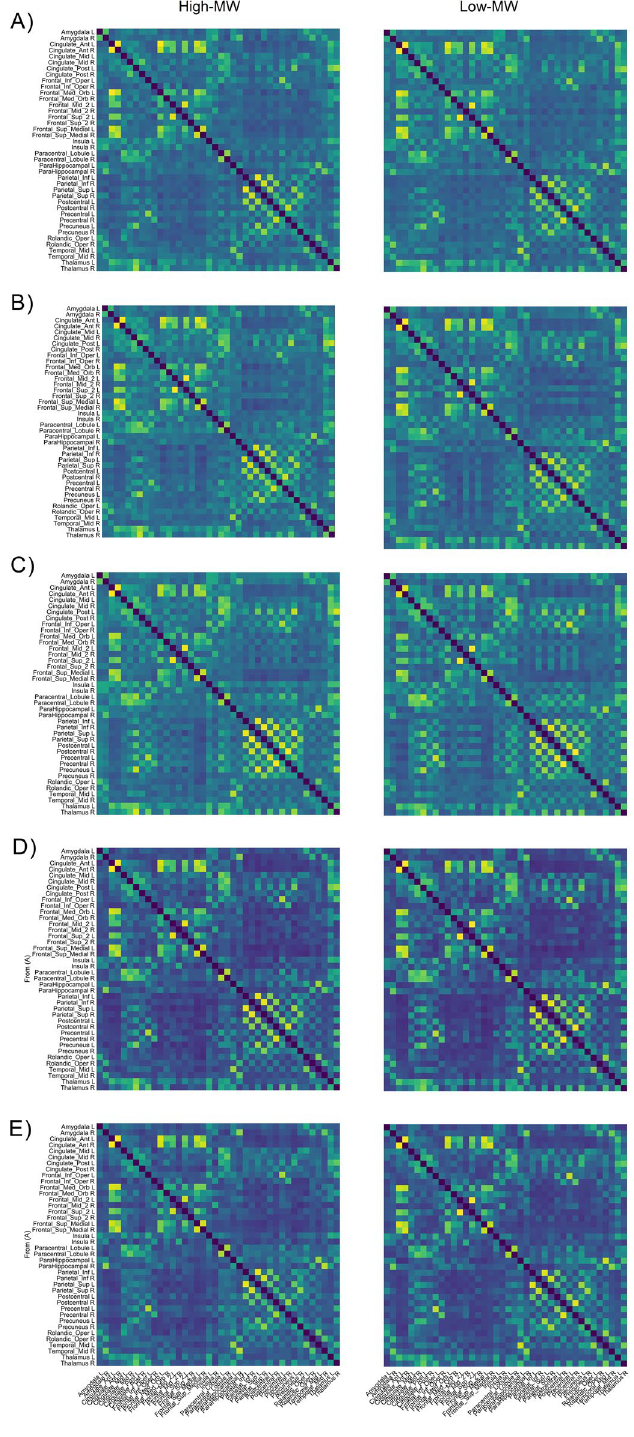
Figure 4. Connectivity matrices covering all 40 included nodes, representing the distribution of synchronizations strength in ( A ) delta, ( B ) theta, ( C ) alpha, ( D ) beta and ( E ) gamma bands separately for groups differing regarding the level of dispositional Mind Wandering. Matrices of the High-MW group are on the left, and the Low-MW on the